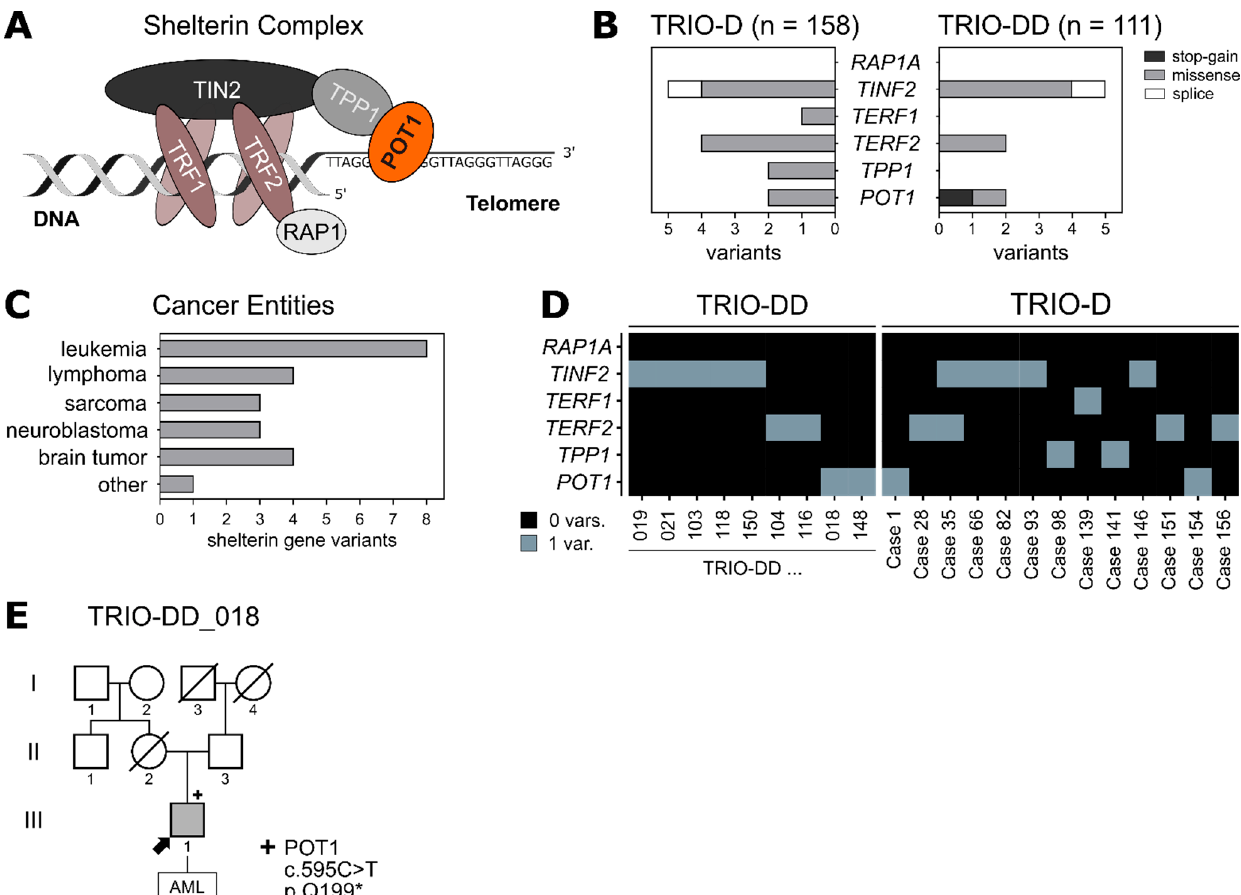
Figure 1. ( A ) Schematic drawing of the shelterin complex. POT1 (orange) is associated with the core complex via TPP1. ( B ) Two pediatric patient cohorts (TRIO-D, n = 158; TRIO-DD, n = 111) were analysed for germline variants within the shelterin complex genes. Only protein-altering variants with a MAF < 0.2% (healthy population) were included. ( C ) Tumor entities of the patients harboring the shelterin complex variants identified in ( B ). ( D ) Distribution of the protein-altering variants from ( B ) among the patients. ( E ) Family pedigree of the patient carrying the heterozygous germline POT1 variant p.Q199*. The index patient is marked with an arrow. Variant carrier is marked with “+”. Half-siblings were not included.